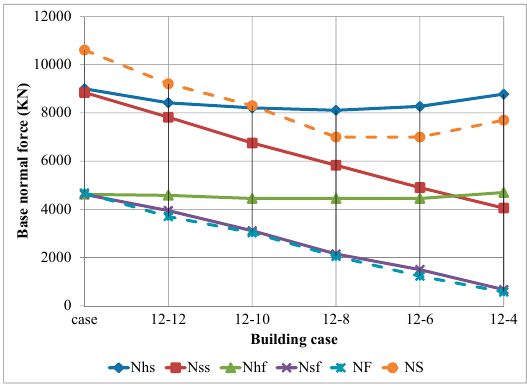
Figure 9. Base normal force in buildings with different configurations.